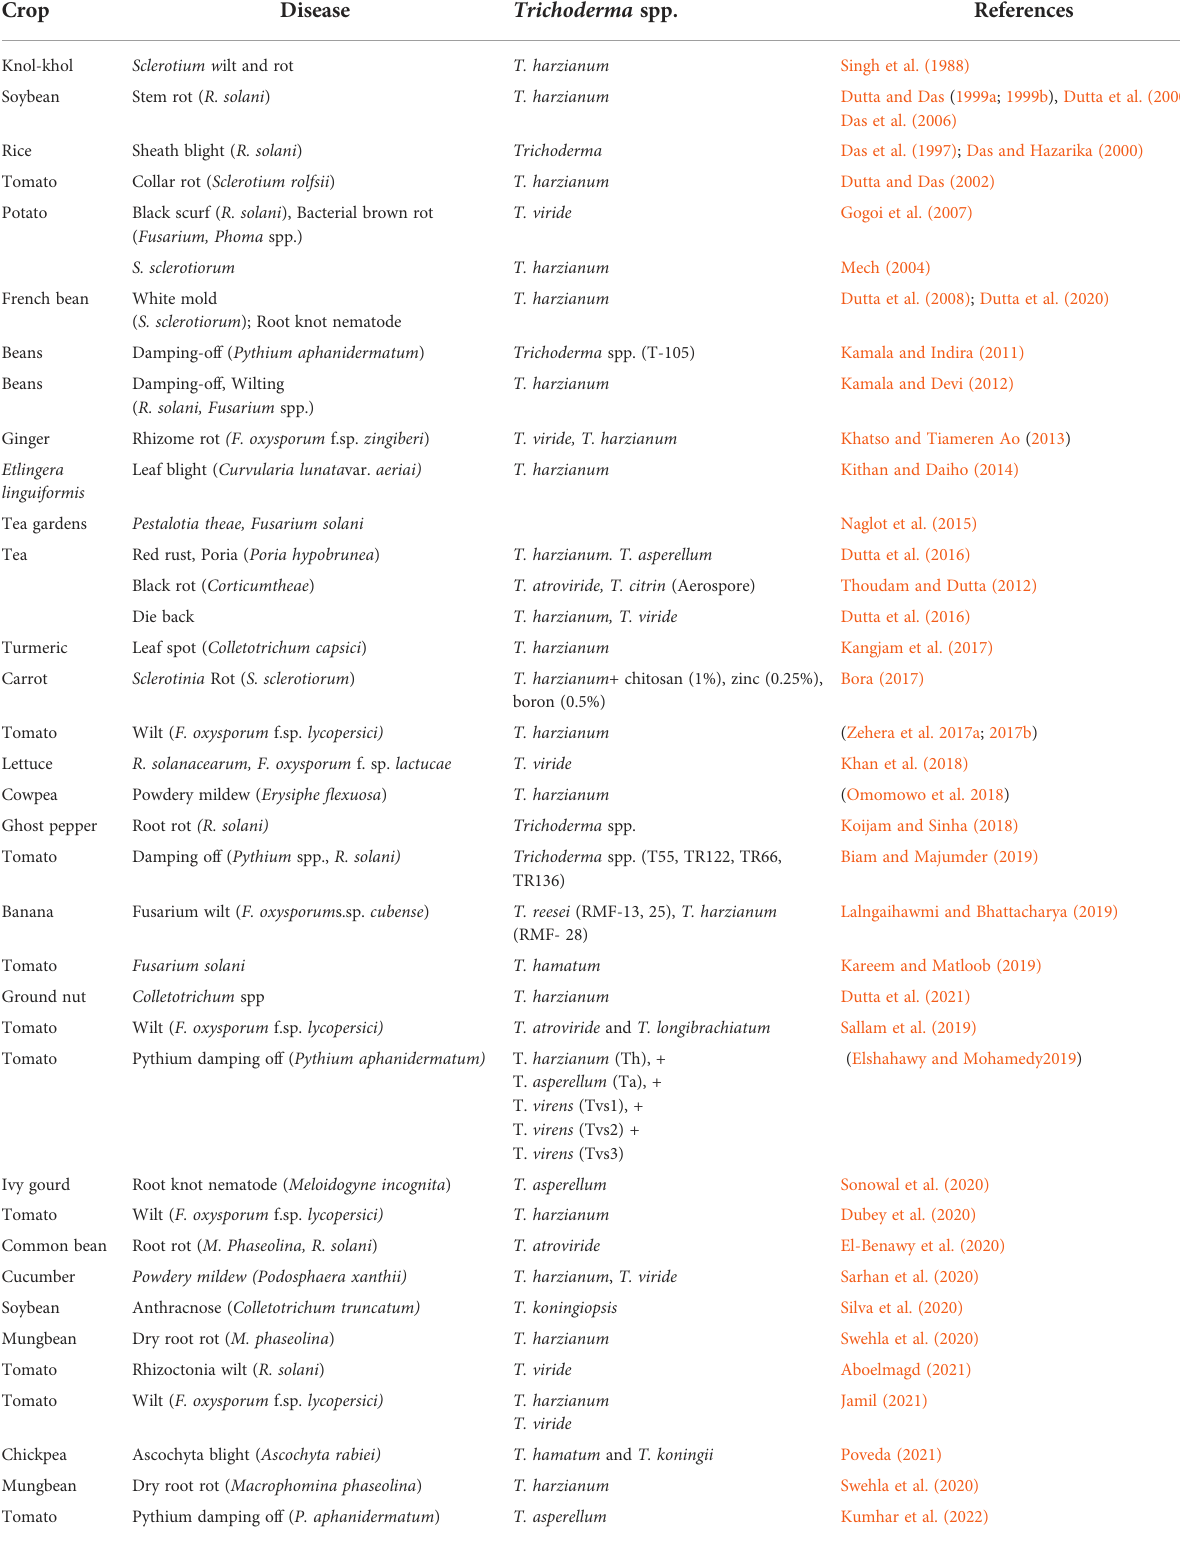
TABLE 7 Application of Trichoderma species as fungal biocontrol agents against various crop diseases. Crop Disease Trichoderma